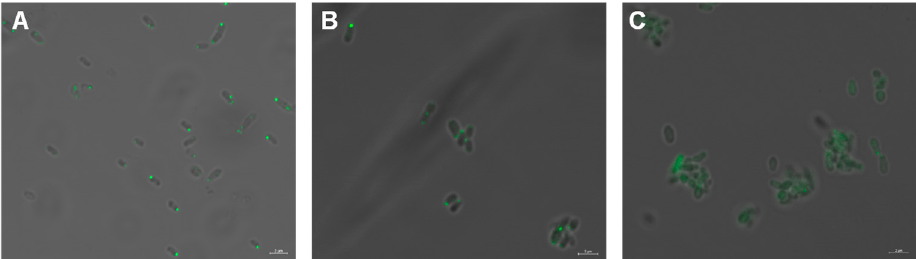
Figure 7. Effects of the substitution of key residue Phe328 on the cellular localization of MCP 514 . Key residue Phe328 in the hairpin subdomain of MCP 514 was replaced by Ala, Pro or Trp to generate three MCP 514 variants, MCP 514F328A ( A ), MCP 514F328W ( B ) and MCP 514F328P ( C ). Three MCP 514 variants were fused to eGFP and expressed as the eGFP-MCP 514 variant in the MCP 514 -deficient mutant ∆ 514, respectively. A. fabrum mutant ∆ 514 cells expressing these eGFP-MCP 514 variant fusion proteins were grown to the middle-log phase and observed by using confocal laser-scanning microscopy.